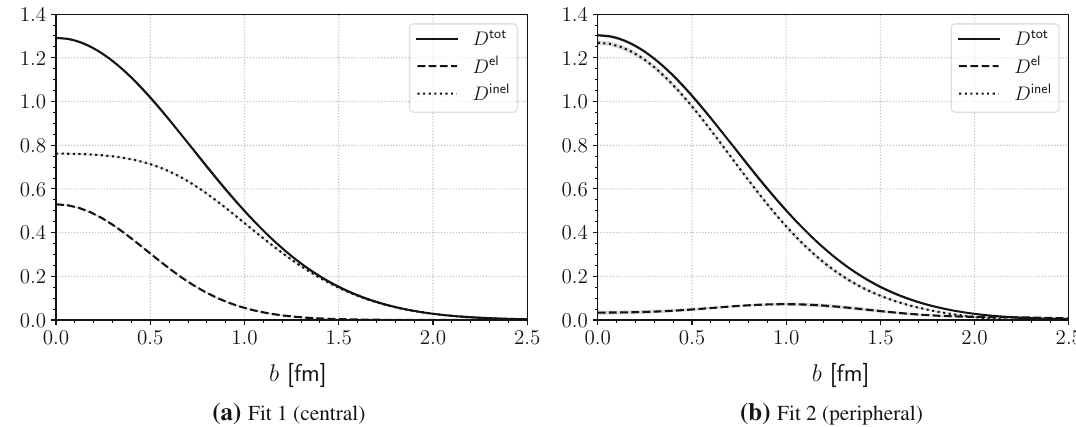
Fig. 5 Proton-proton profile functions D ( b ) at energy of 52.8 GeV determined on the basis of Eqs. (38), (35) and (44). Full line corresponds to total profile function, dashed line to elastic one and dotted line to inelastic one